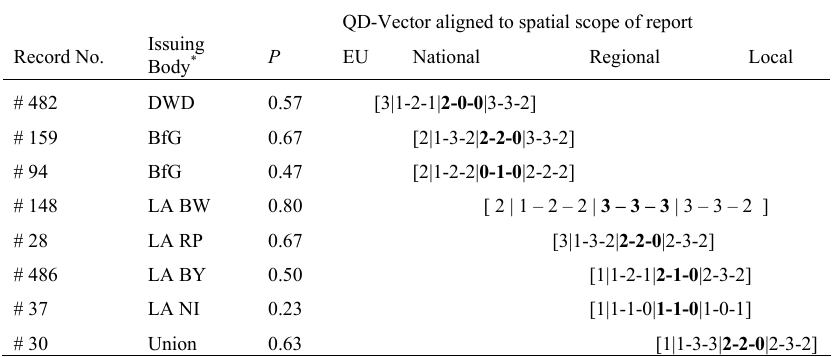
Table 4: Overview of the flood event reports available for the flood in Oct.-Nov. 1998 and their quality assessment. For each document the respective record number, the issuing body, the Pedigree and the vector of the scores assigned in each quality dimension (in the order given by the QAF, aligned to spatial scope of the report) are given. The contextual dimensions are highlighted in bold. QD-Vector aligned to spatial scope of